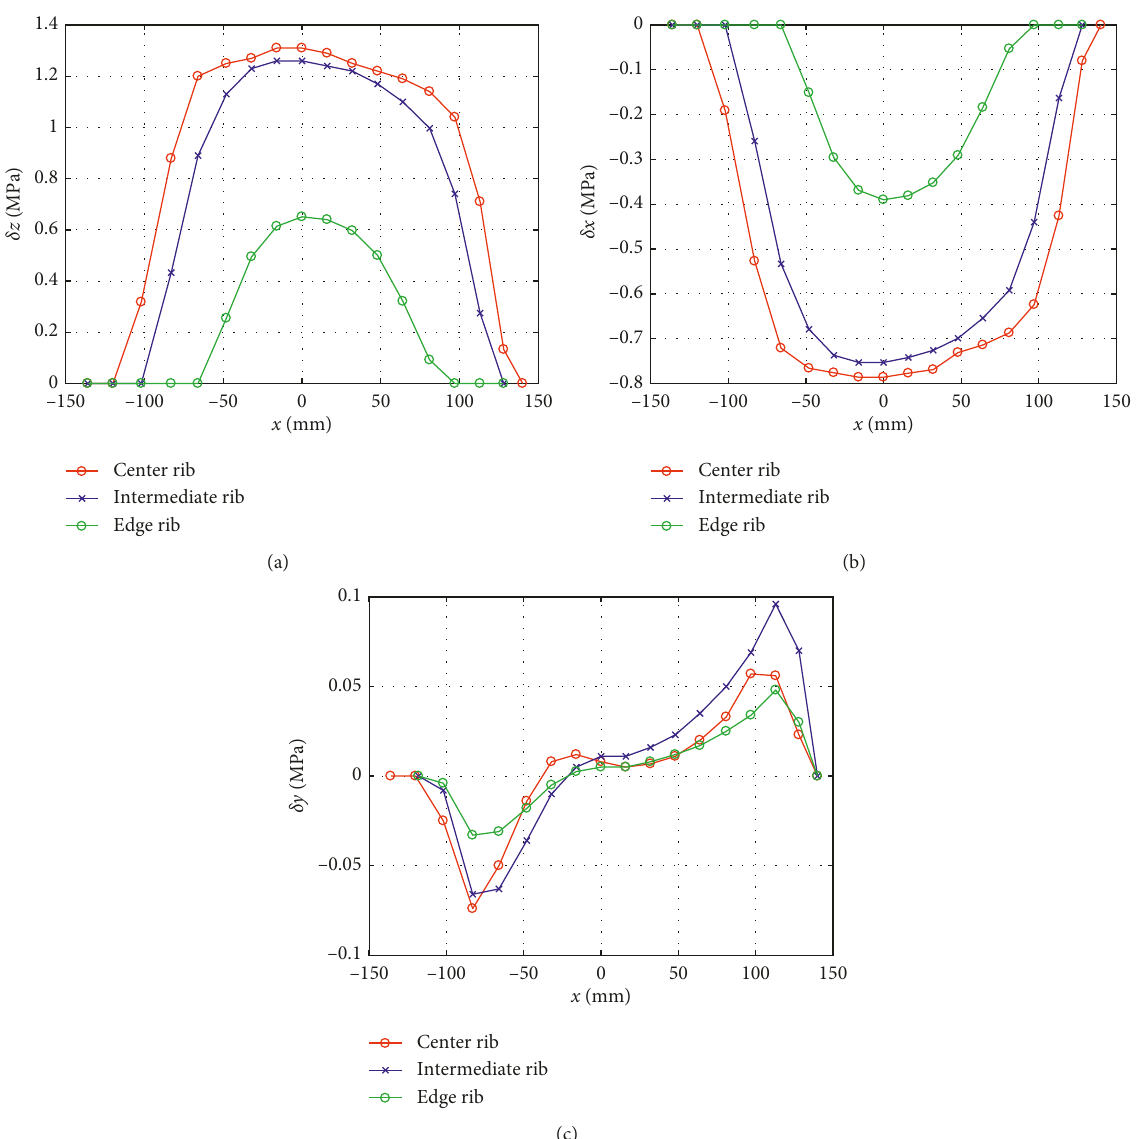
Figure 5: Comparison of contact stresses in (a) vertical, (b) longitudinal, and (c) transverse directions at full acceleration